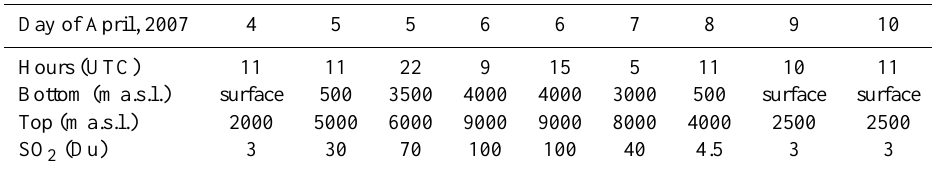
Table 1. Evolution of the column size and the SO 2 concentration introduced into the model over La R´eunion between 4 April and 10 April, 2007. Day of April, 2007 Hours (UTC) 11 11 22 15 11 10 11 Bottom (ma.s.l.) surface 500 3500 4000 4000 3000 500 surface surface Top (ma.s.l.) 2000 5000 6000 9000 9000 8000 4000 2500 2500 SO 2 (Du) 3 30 70 100